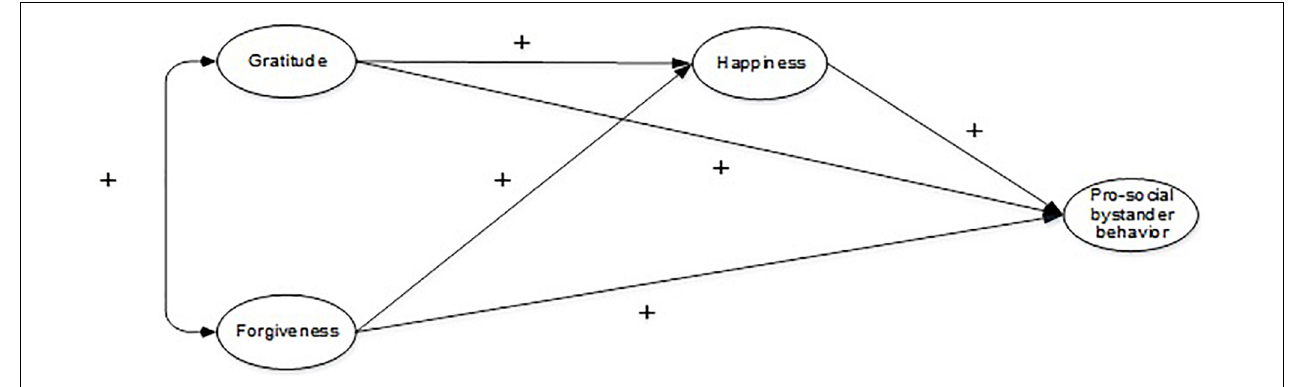
FIGURE 1 | Theoretical model of the relations between forgiveness, gratitude, happiness, and prosocial bystander behavior.